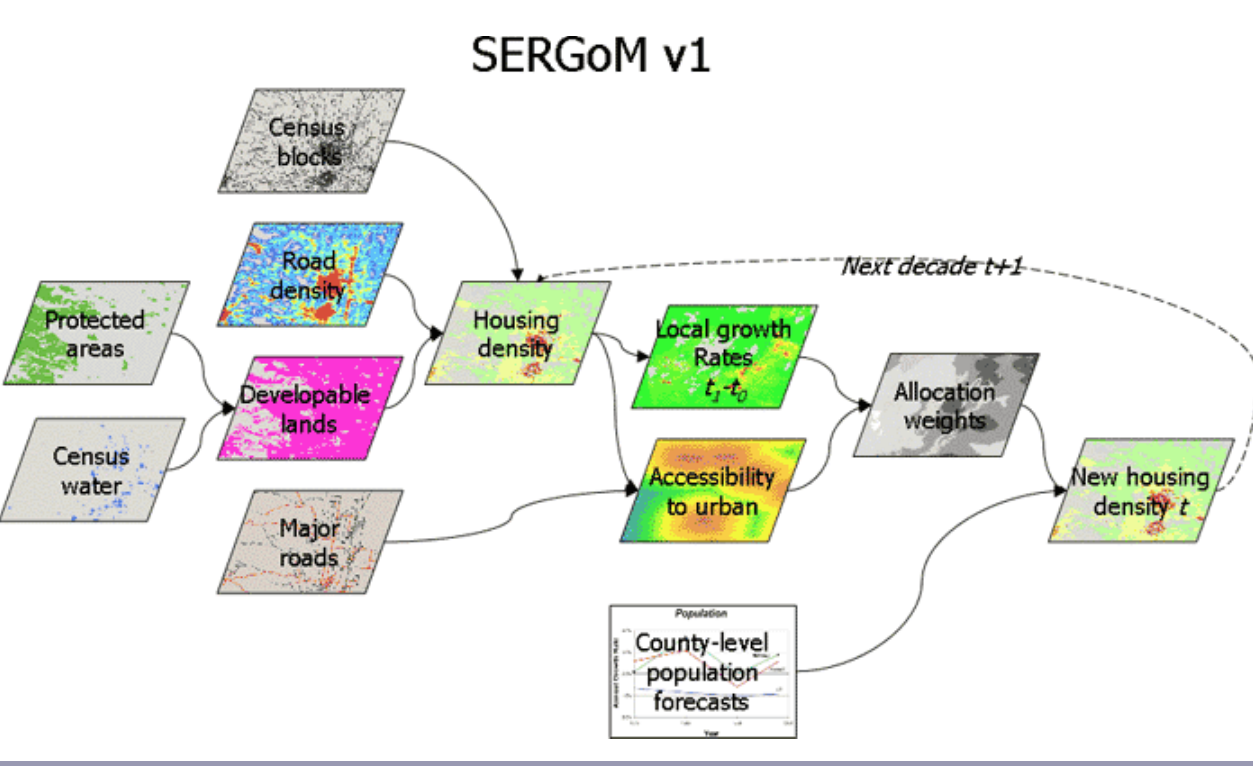
Fig. 1. A basic logic diagram of the Spatially Explicit Regional Growth Model (SERGoM